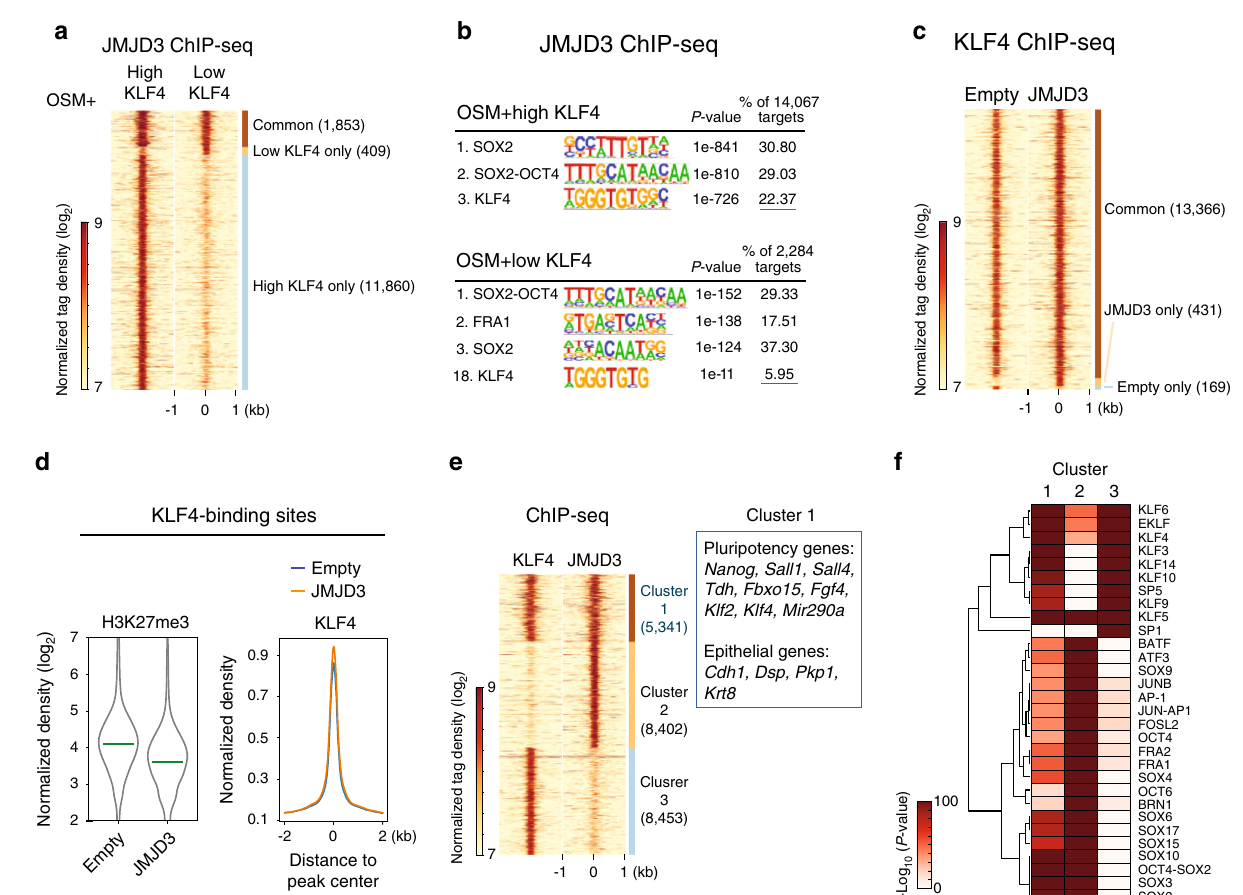
Fig. 5 The genome-wide cooperation of KLF4 and JMJD3 during reprogramming. a Tag density heatmaps of JMJD3 peaks in P2 MEFs transduced with OSM + JMJD3 and low or high level of KLF4 in medium with Vc at day 5. Peaks were merged into the same genomic loci if the summits were within 400 bp, and the resulting merged peaks were allocated to clusters as indicated: common between high and low (Common), low KLF4-speci fi c (Low KLF4 only), and High KLF4-speci fi c (High KLF4 only). b De novo motif discovery by HOMER at JMJD3 binding sites. c Tag density heatmaps of KLF4 binding in P2 MEFs transduced with OSKM and Empty or JMJD3 in medium with Vc at day 5. Peaks were merged into the same genomic loci if the summits were within 400 bp and the resulting merged peaks were allocated to clusters as indicated: common between Empty and JMJD3 (Common), JMJD3-speci fi c (JMJD3 only), and Empty-speci fi c (Empty only). d Violin plots of the levels of H3K27me3 at KLF4-binding sites (left panel) and the pileup tag density plots of KLF4- binding intensity (right panel) with Empty or JMJD3. e Tag density heatmaps of JMJD3 or KLF4 peaks. Peaks were merged into the same genomic loci if the summits were within 400 bp, and the resulting merged peaks were allocated to the indicated clusters. Cluster 1: common between JMJD3 and KLF4; Cluster 2: JMJD3-speci fi c; Cluster 3: KLF4-speci fi c. Representative pluripotency and epithelial genes co-bound by KLF4 and JMJD3 in Cluster 1 are listed. f Enrichment of speci fi c transcription factor motifs (from HOMER) in each cluster. Data were grouped based on a Euclidean distance matrix and complete